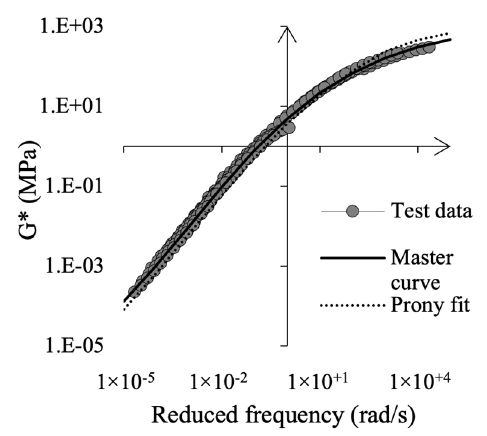
Figure 3. Results from DSR of asphalt mortar, master curve fitting and Prony series fitting at 20 °C.